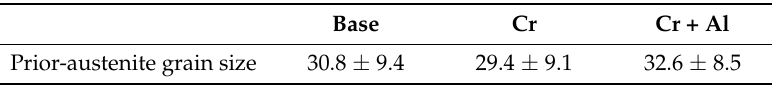
Figure 4. SEM micrographs of three low ‐ carbon bainitic steels after isothermal holding at 350 °C for 3600 s: ( a ) base, ( b ) Cr addition, and ( c ) Cr and Al addition. Table 2. Prior-austenite grain sizes of three steels ( µ